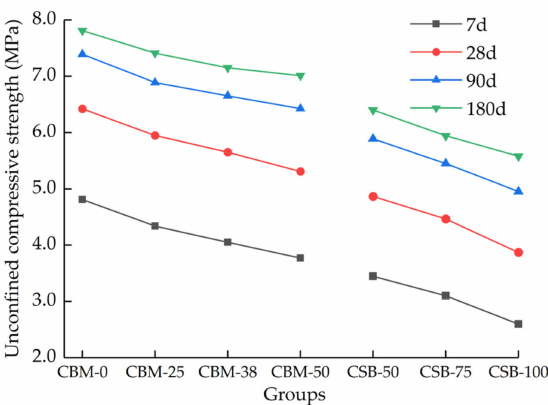
Figure 9. The unconfined compressive strength of mixture at different curing